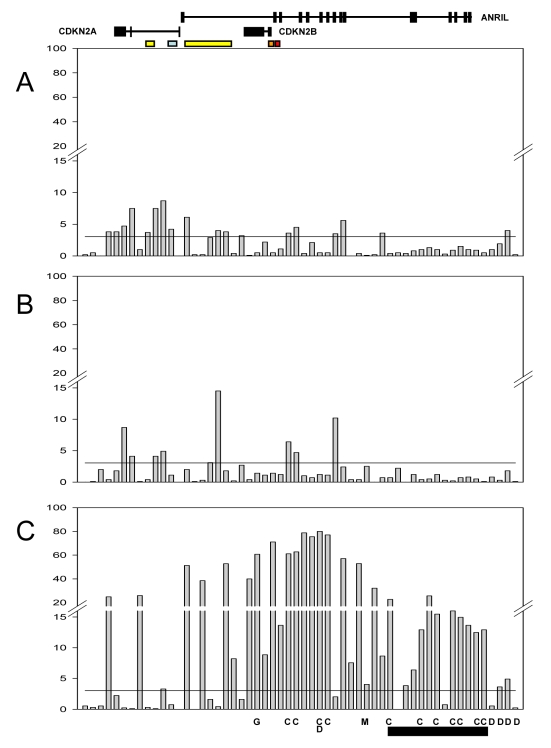
Significance of association with expression for SNPs in the combined population.The Y-axis represents the −log P value for individual SNPs (shown in chromosomal order along the X-axis) for: CDKN2A (A); CDKN2B (B); ANRIL (C). The horizontal black line on each graph represents the significance threshold after adjustment for multiple testing (family wise error rate of 0.05 corresponding to −log10P = 3.05). The relative location of genes and promoter elements is represented at the top (CDKN2A and CDKN2A/ARF promoters yellow; ANRIL promoter blue; CDKN2B promoter orange; CDKN2A/ARF regulatory domain red). Letters along the bottom represent associations from GWA studies (C = CAD, D = diabetes, M = melanoma, G = glioma) and the black bar at the bottom represents the core risk haplotype for CAD defined by Broadbent et al
[35].